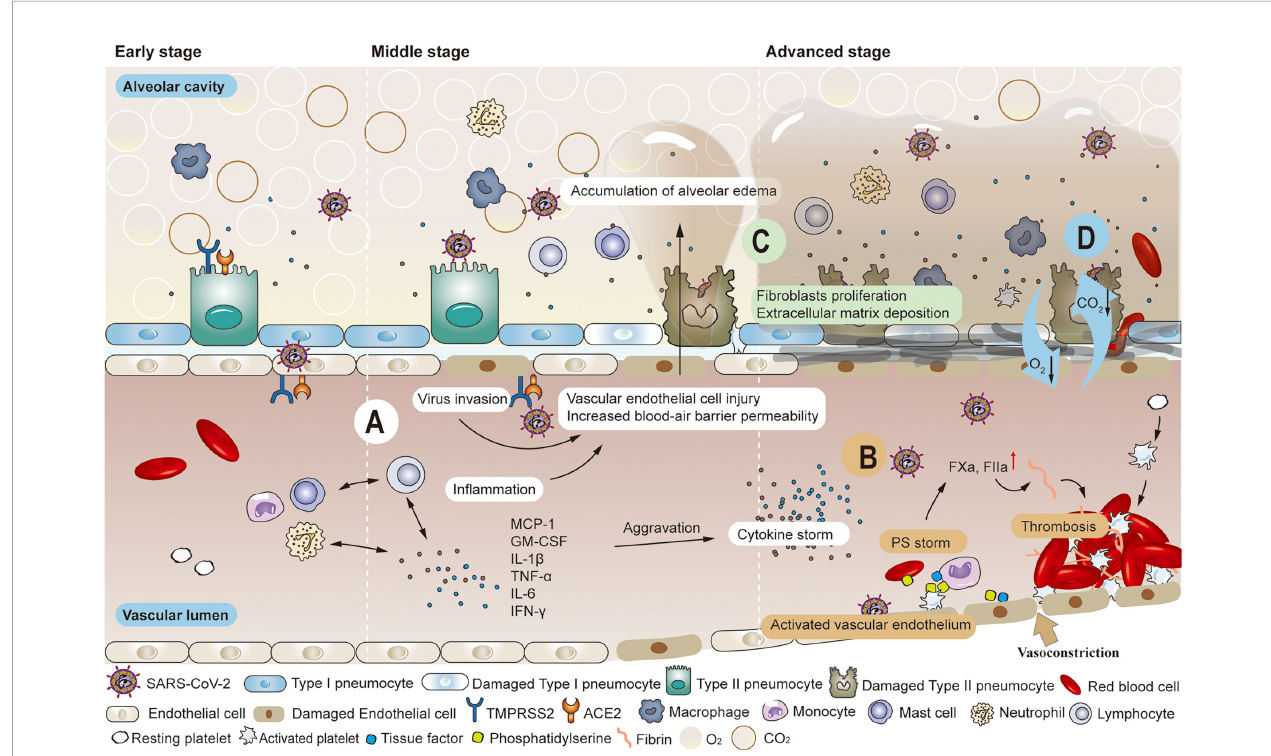
FIGURE 1 | Common pathological changes in the lungs of patients with COVID-19. (A) SARS-COV-2 enters local alveolar type II cells along the airway, replicates, and damages the targeted cells. Various immune cells are mobilized and activated wherever the virus goes, inducing the release of in fl ammatory factors such